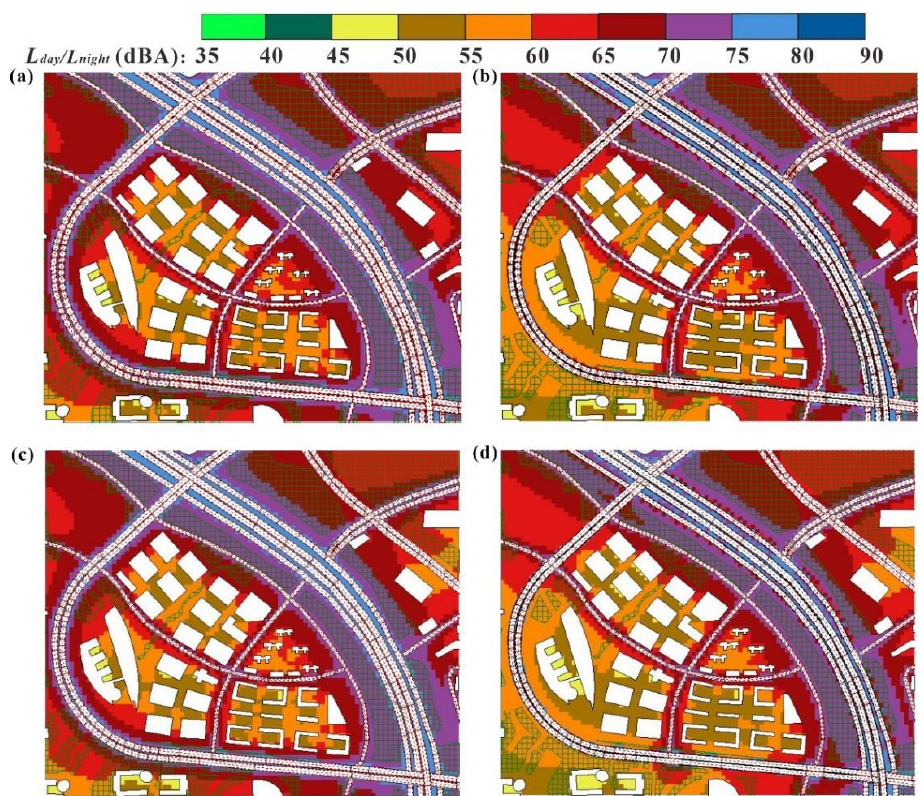
Figure 3. Geometries of different noise barriers. ( a ) L-shape (left); ( b ) L-shape (right); ( c ) T-shape; ( d ) cylindrical; ( e ) roof edge; ( f ) curved cantilever (left); ( g ) curved cantilever (right).